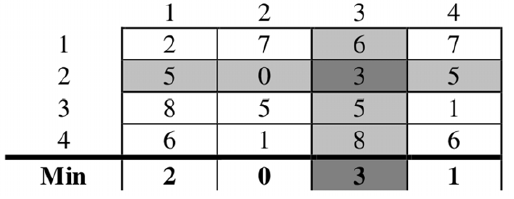
Figure 1. Sample pairwise similarity matrix for fuzzy partition matrices’ rows relabeling. Each element in this sample pairwise matrix measures the similarity between a cluster from one clustering result and a cluster from another clustering result. In the min-max relabelling approach, the minimum value of each column is calculated, as shown in the row below the matrix, and then the maximum of these minima is considered. The maximum of the minima is shaded in dark gray and the clusters corresponding to the row and the column containing this value are matched. This row and this column are then removed and the process is repeated until each cluster in the first result is matched with a cluster from the second result.